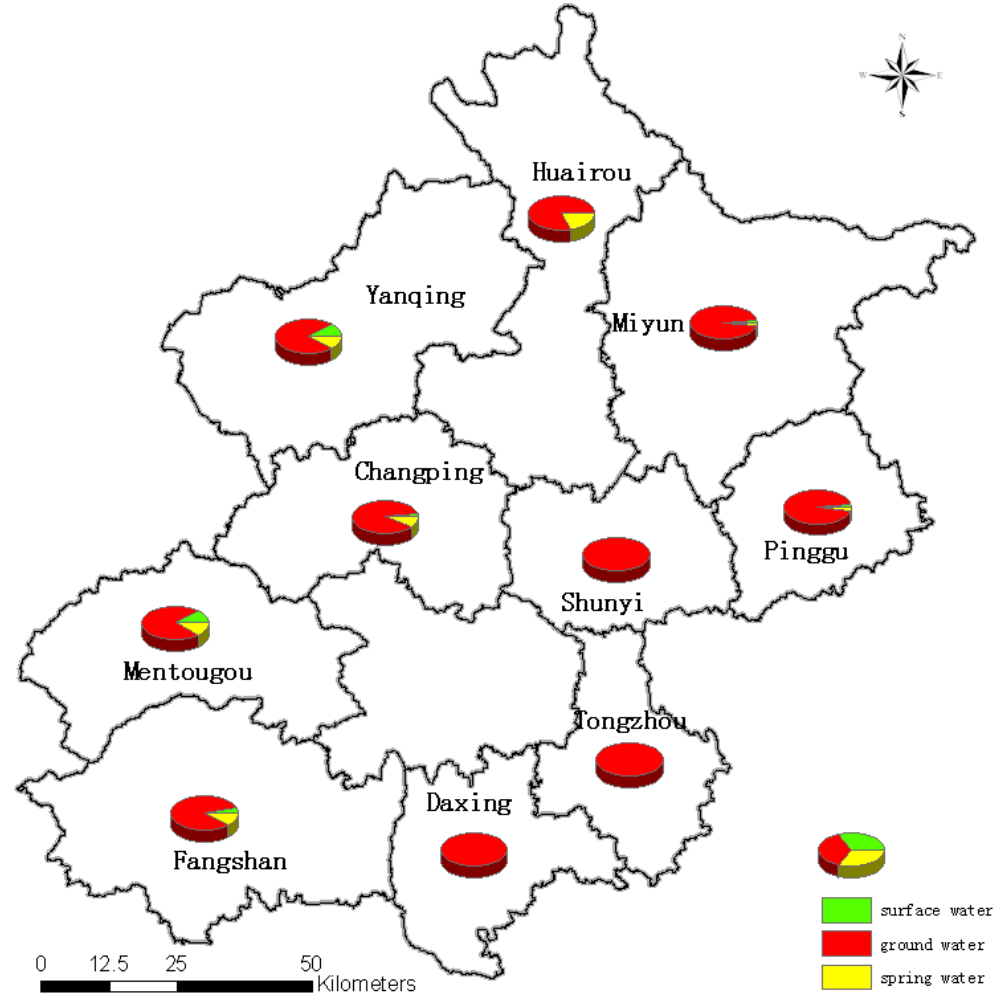
Figure 3. Distribution of water source types in rural areas around